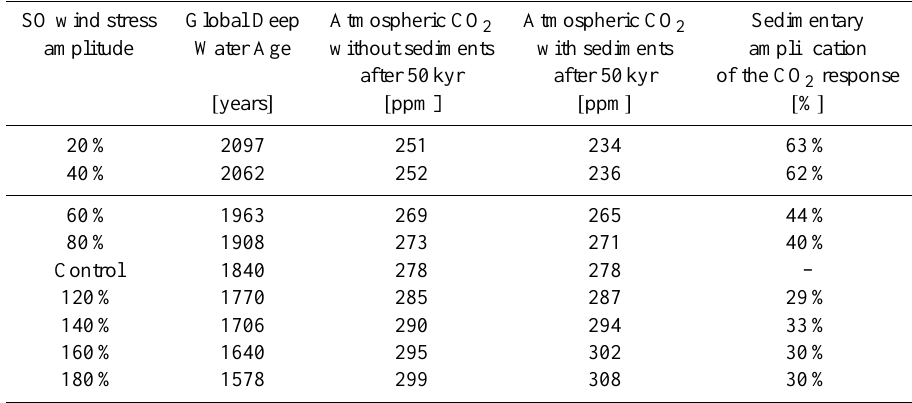
Table 4. Long-term response in atmospheric CO 2 and amplification by sedimentary